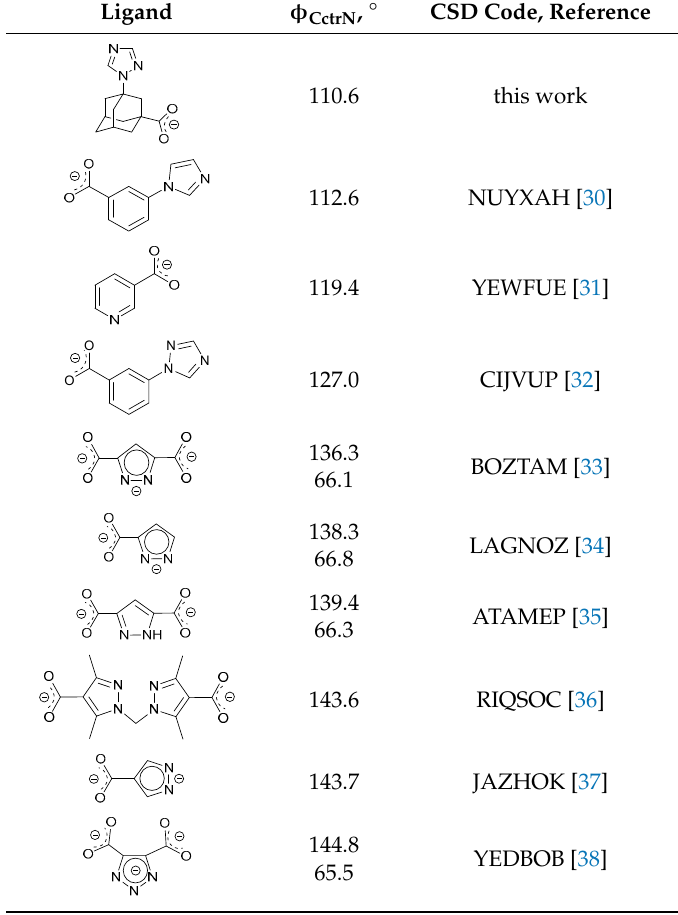
Table 1. Angle-shaped ligands commonly used for the synthesis of coordination polymers. Ligand ϕ CctrN ,